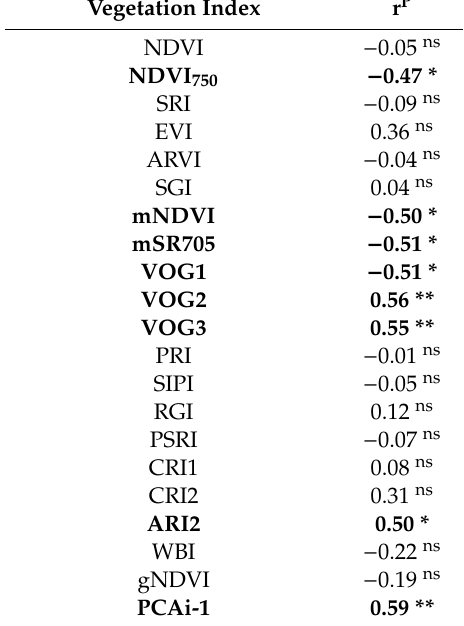
Table 3. Spearman rank order correlation between the density of the Phragmites australis patch and